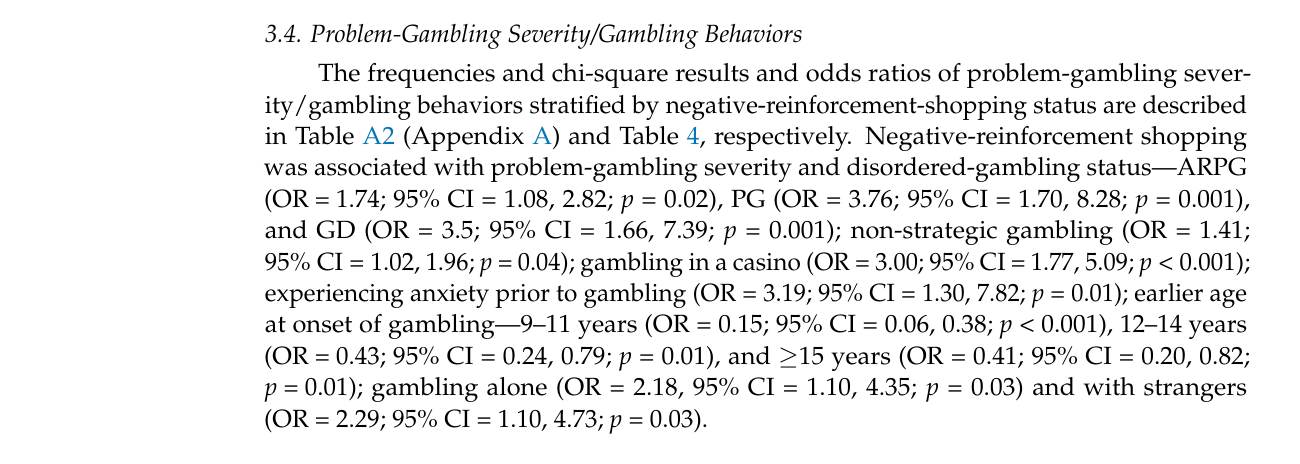
Table 4. Problem-gambling severity/gambling behaviors stratified by negative-reinforcement status (odds